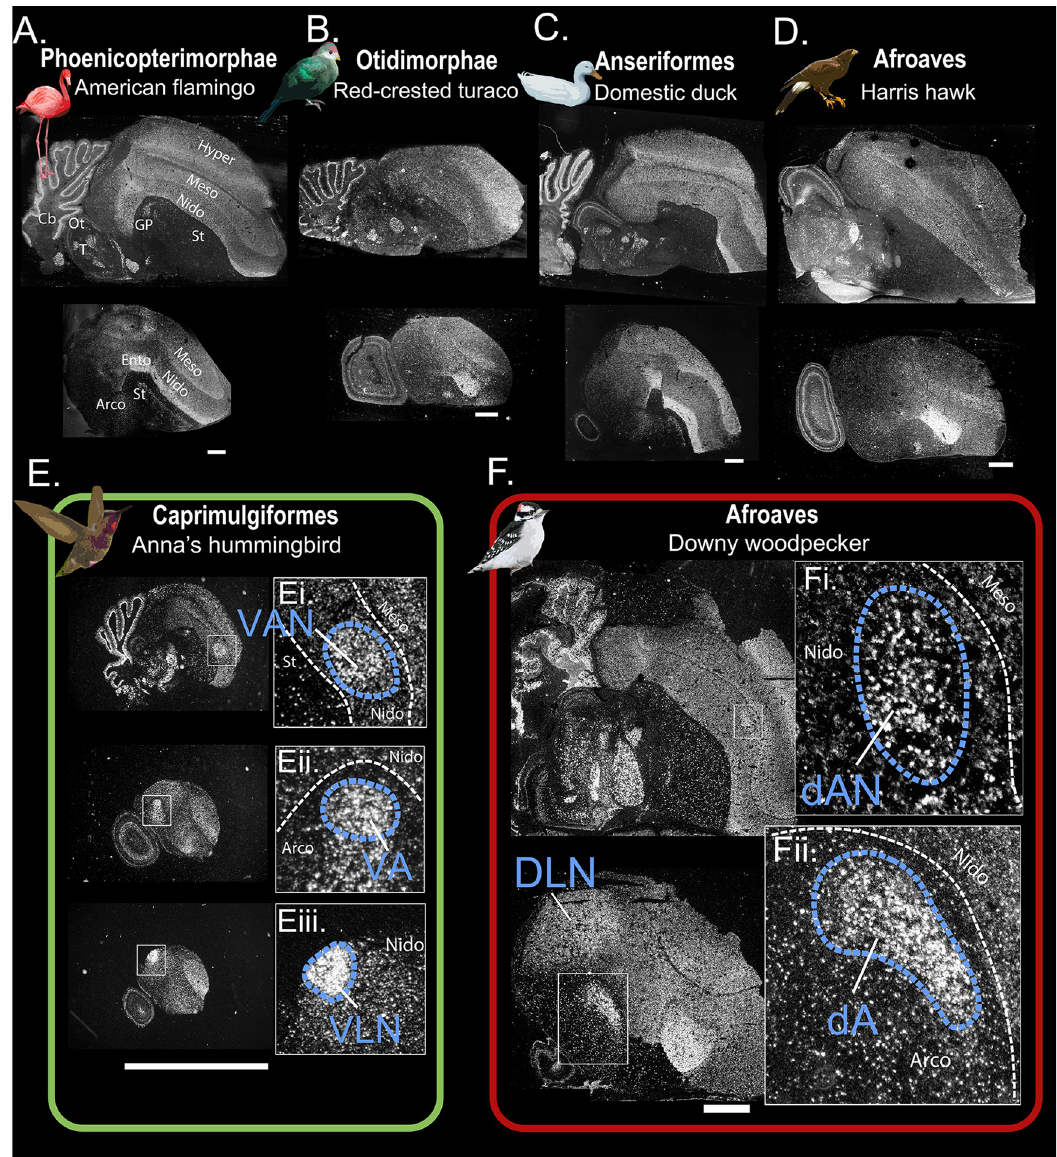
Fig 2. Identification of forebrain structures with specialized parvalbumin ( PV ) mRNA expression. (A-F) Representative radioactive in situ hybridization microscope images of PV mRNA in species representing 8 different avian orders (see S1 Fig for penguin and emu). PV -rich forebrain nuclei were present in only (E) vocal learning hummingbirds (positive control) and (F) downy woodpeckers. (Ei-iii) High magnification of 3 telencephalic “song control” nuclei in hummingbirds. (Fi) High magnification of the woodpecker drumming nucleus of the anterior nidopallium (dAN); and (Fii) drumming nucleus of arcopallium (dA). Each scale bar is equal to 2 mm. Neuroanatomical markers shown in “A” are as follows: Hyper, hyperpallium; Meso, mesopallium; Nido, nidopallium; GP, globus pallidus; T, Thalamus; Ot, optic tectum; St, striatum; Arco, arcopallium; Ento, entopallium. White dashed lines in high-magnification images (Ei-iii and Fi-ii) indicate boundaries for different telencephalic regions (e.g., boundary between nidopallium and mesopallium), whereas blue dashed lines indicate specialized PV regions identified in Anna’s hummingbirds and downy woodpeckers. Image credits : flamingo from Wilfredo Rodríguez; turaco from Edelmauswaldgeist; duck from Orso della campagna e Papera dello stagno; hawk from Cheva; hummingbird from Stickpen , and downy woodpecker from Greg Schechter . All image licenses : CC Public Domain via WikiMedia .